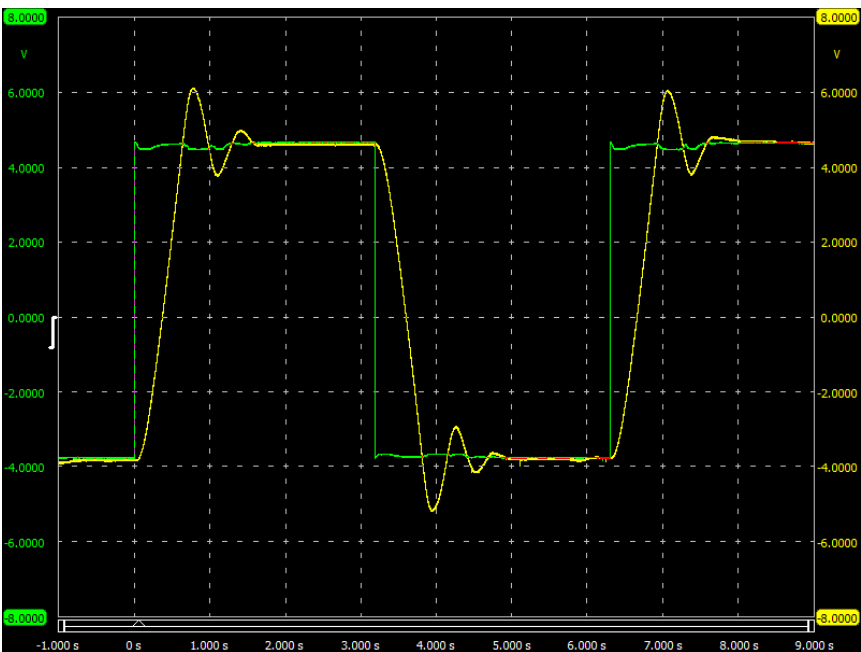
Fig. 10. Output response with ringing (microcontroller-based controller, Kp =25 and Kv